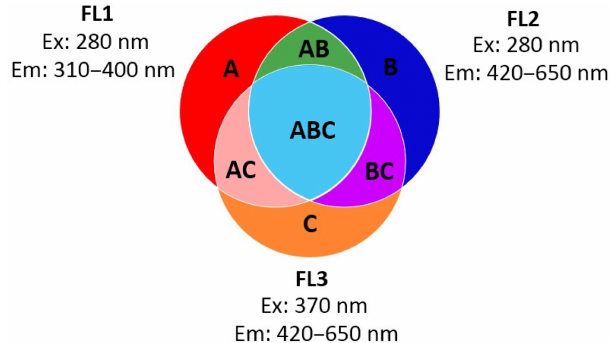
Figure 1. Particle type classification, as introduced by introduced by Perring et al. (2015). Large circles each represent one fluores- cence channel (FL1, FL2, FL3). Colored zones represent particle types that each exhibit fluorescence in one, two, or three